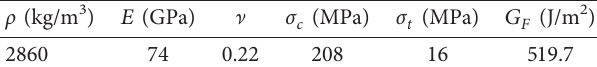
Figure 5: Time history curve of different energy components in rock mass. Table 4: Main mechanical parameters of